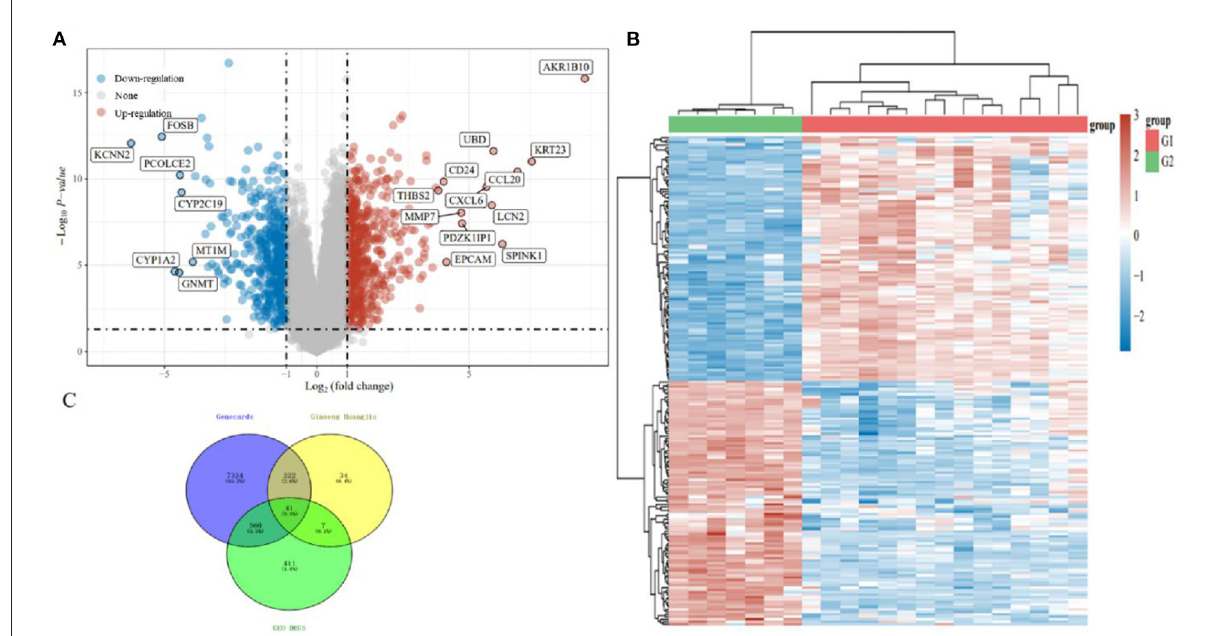
FIGURE10 (A) A volcano plot was constructed using the fold change values and P-adjust. Red and blue dots indicate upregulated and downregulated genes, respectively. (B) Heatmap of the differential gene expression. Different colors represent the trend of gene expression in different tissues. The top 50 upregulated and top 50 downregulated genes are shown in (C) : intersected mRNAs from GeneCards databases, ginseng Huang jiu, and ALD.